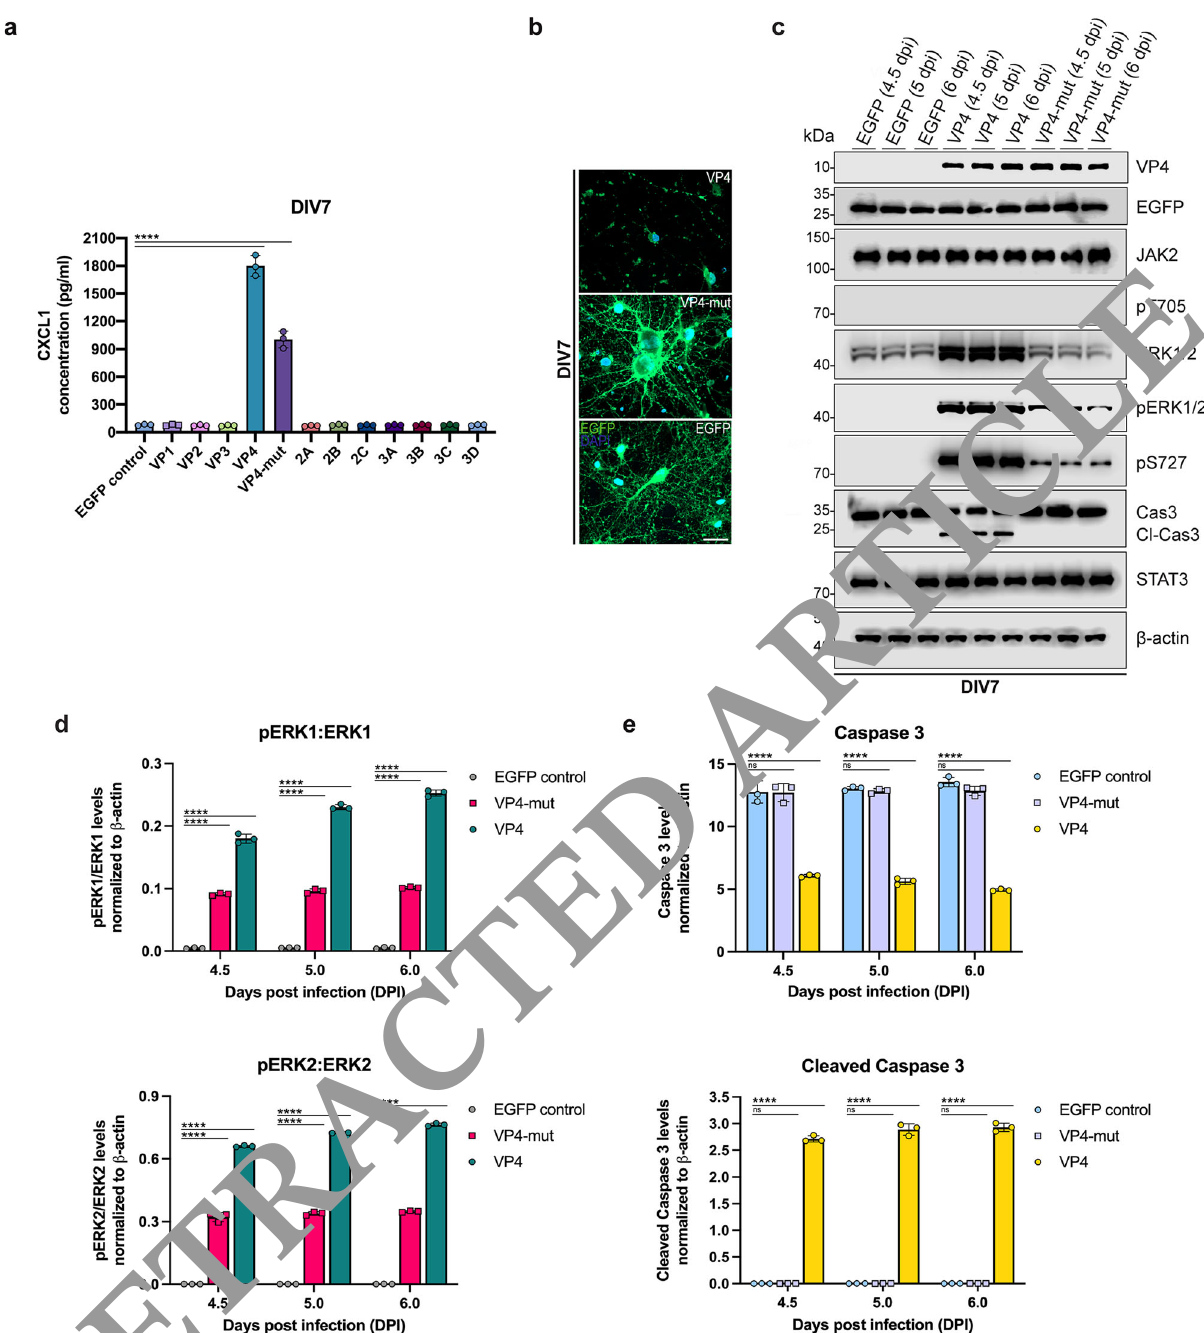
Fig. 7 HEVA71 VP4 induces CXCL1 secretion for HEVA71 replication and subsequent viral neuropathogenesis in neuronal cultures. a CXCL1 levels were elevated in culture supernatants when VP4 and VP4-mut were expressed. Higher levels of the chemokine were detected in samples expressing wildtype VP4. b Immuno fl uorescence images of control (EGFP)- or VP4 (wildtype and mutant)- expressing neuronal cultures. Neurite disintegration was only observed in wildtype VP4-expressing neuronal cultures. Scale bars represent 20 µ m. c Immunoblots of cell lysates from control (EGFP)-, VP4- or VP4-mut- expressing neurons against VP4, EGFP, ERK1/2, pERK1/2, pS727 (STAT3), JAK2, pT705 (STAT3), STAT3, caspase 3 and cleaved caspase 3. Immunoblot representative of 3 biological repeats is shown. Bar charts below show quanti fi cations for each protein. d pERK1/2 to ERK1/2 ratios were higher in VP4- expressing neuronal cultures as compared to VP4-mut or EGFP controls at all time points. e Cleaved caspase 3 was detected only in VP4-expressing neuronal cultures. Exact P value for caspase 3: VP4-mut at 6 dpi = 0.6026. β -actin was used as a loading control for immunoblotting experiments. Data are expressed as the average with error bars representing ±SD from 3 independent experiments ( n = 3). Statistical analyses were performed with two-way ANOVA corrected using Bonferroni post-test. (ns > 0.9999 unless speci fi ed, and **** P < 0.0001). Source data are provided as a Source Data fi le.